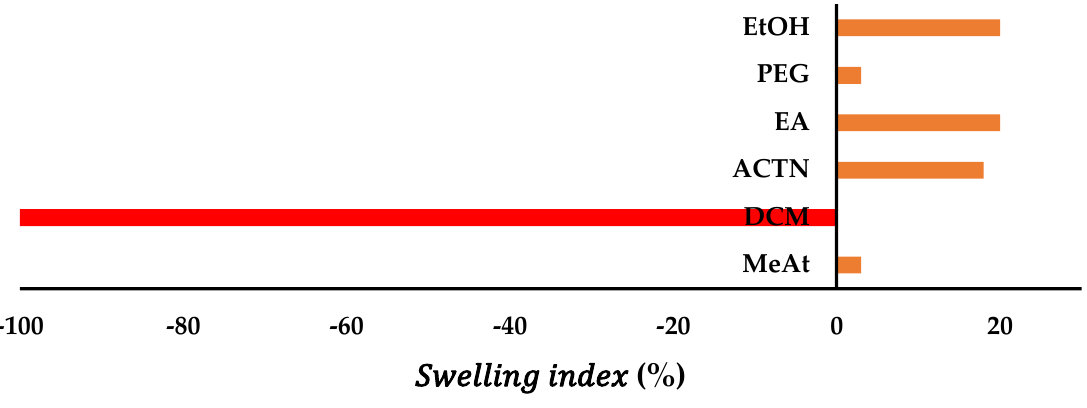
Figure 3. Swelling index percentage of PLA in the selected organic solvents.